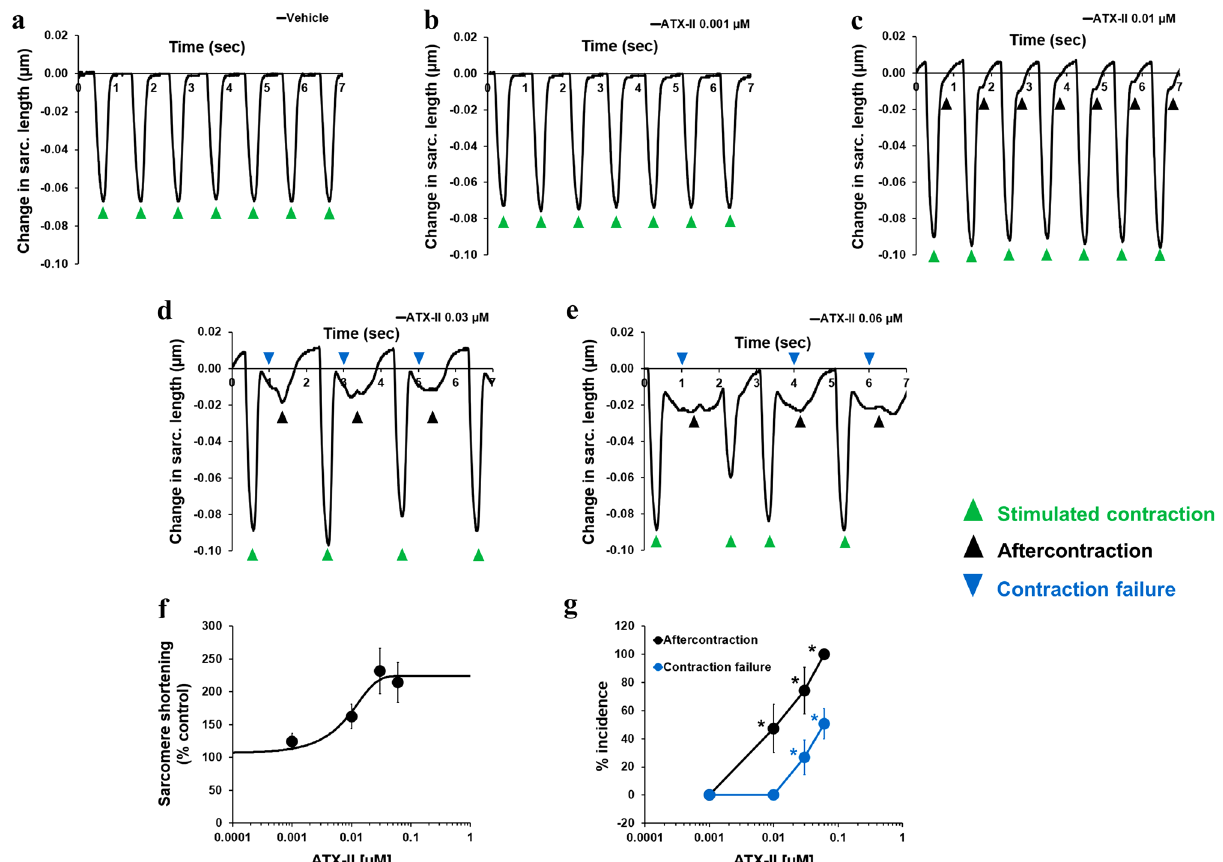
Figure 6. Effects of ATX-II on human ventricular contractility. ( a – e ) show typical contractility transients recorded from a ventricular cell at a pacing of 1 Hz in the presence of vehicle control and after exposure to four ascending concentrations of ATX-II. ( f ) shows ATX-effect curve for sarcomere shortening as a function of concentrations tested (EC 50 = 0.012 µM, n = 6 cells). ( g ) shows mean % incidence of aftercontraction and contraction failure when cardiomyocytes were incubated with ATX-II at 1 Hz pacing frequency. *,* p < 0.05 versus values from vehicle control. IonWizard software (v1.2.22, IonOptix LLC, MA, USA, www. ionop tix. com) and SigmaPlot v14.0 (Systat Software Inc., CA, USA, www. systa tsoft ware. com) were used to generate the representative contractility transients and fitted C-E curve,